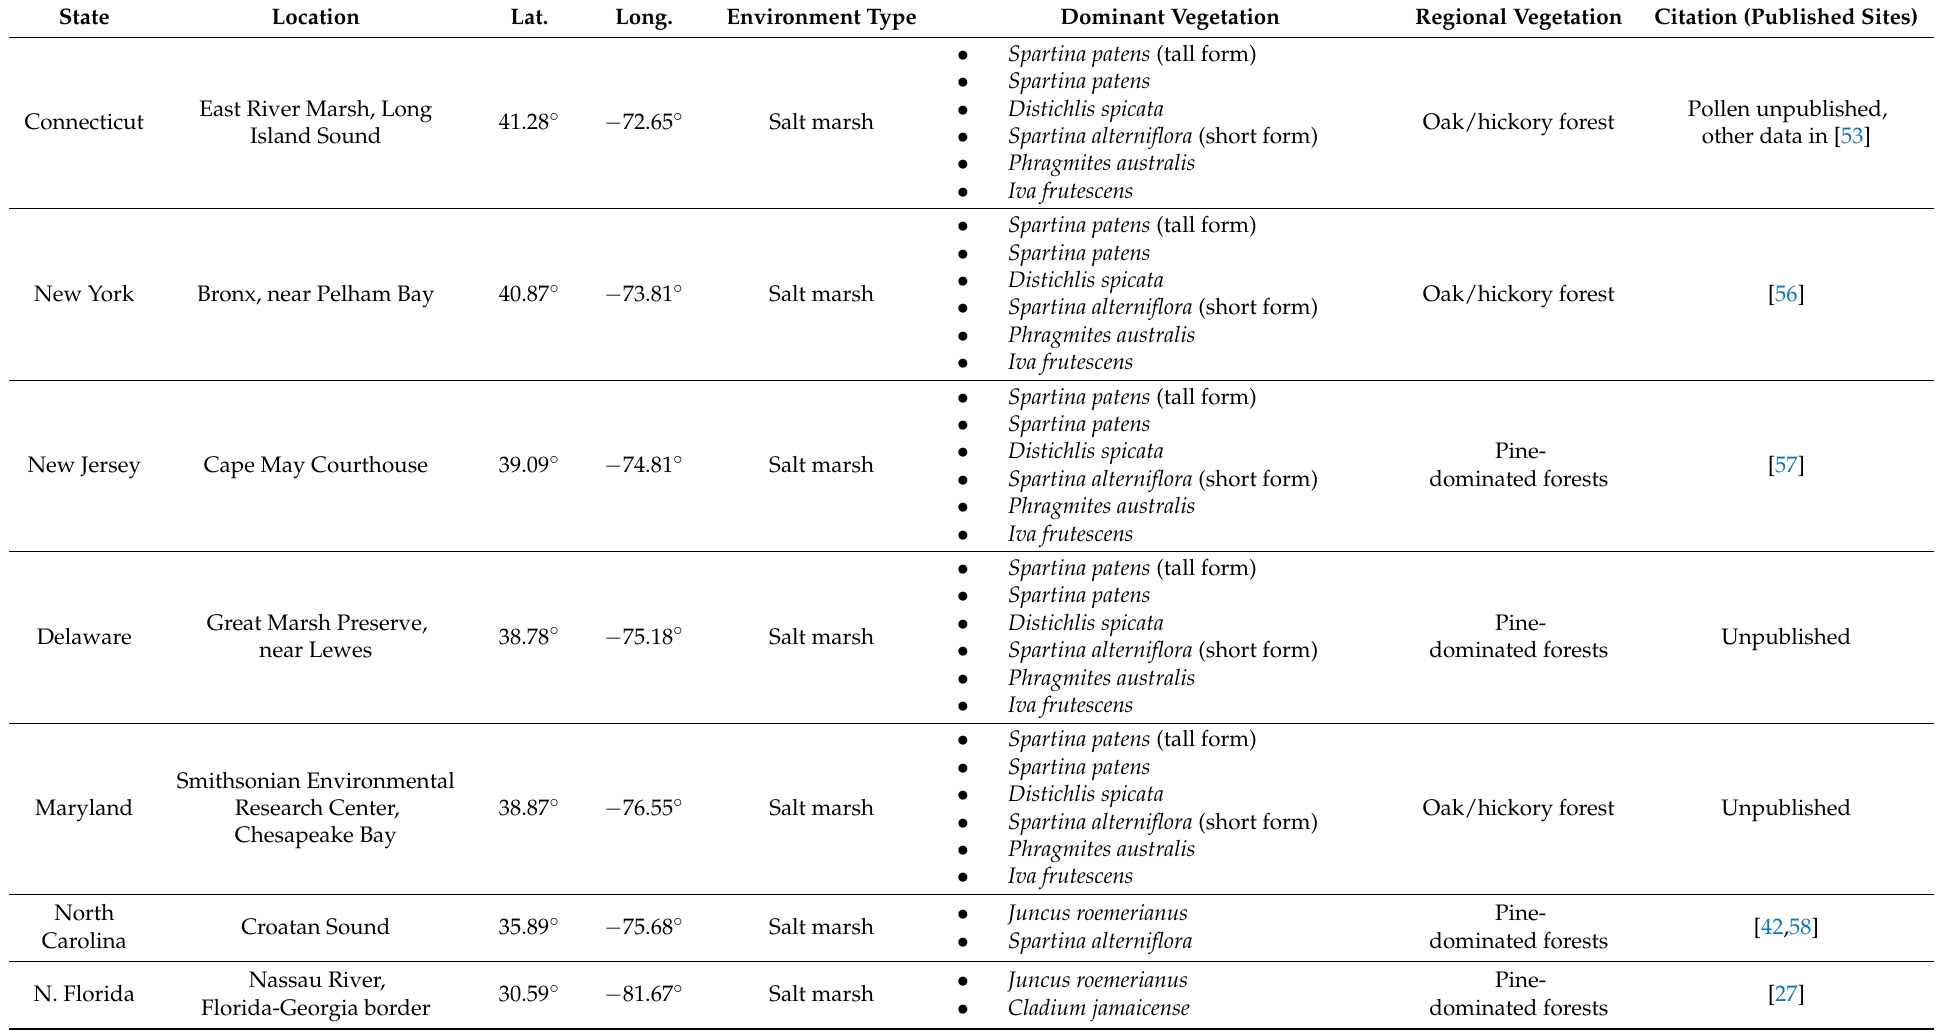
Table 1. Site Descriptions. Regional vegetation identified using [55]. The site description and chronology related to other age markers can be found in the original publication.